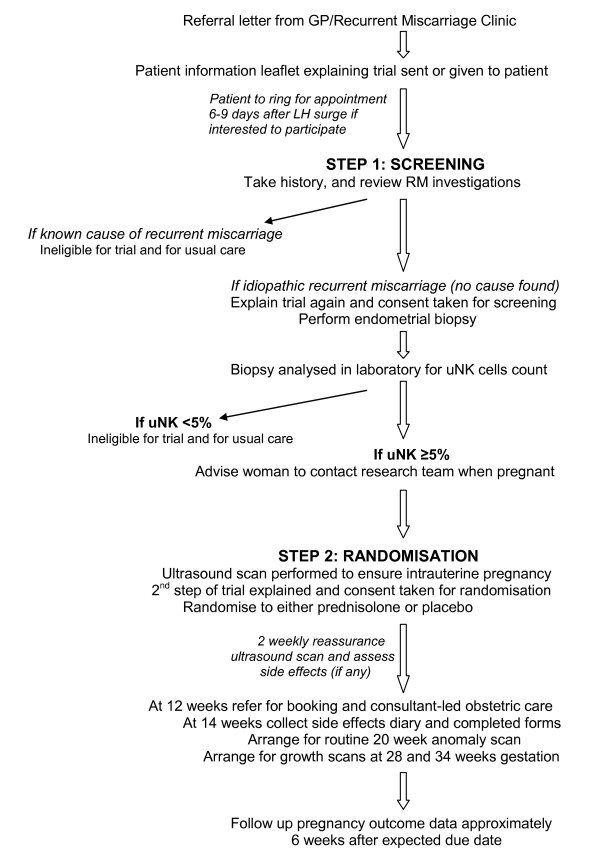
Patient flow during trial.